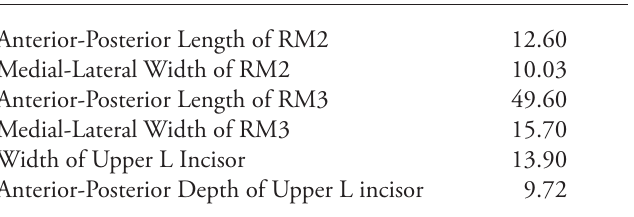
Table 3: Tooth measurements (in mm) of SDSNH 50000 Anterior-Posterior Length of